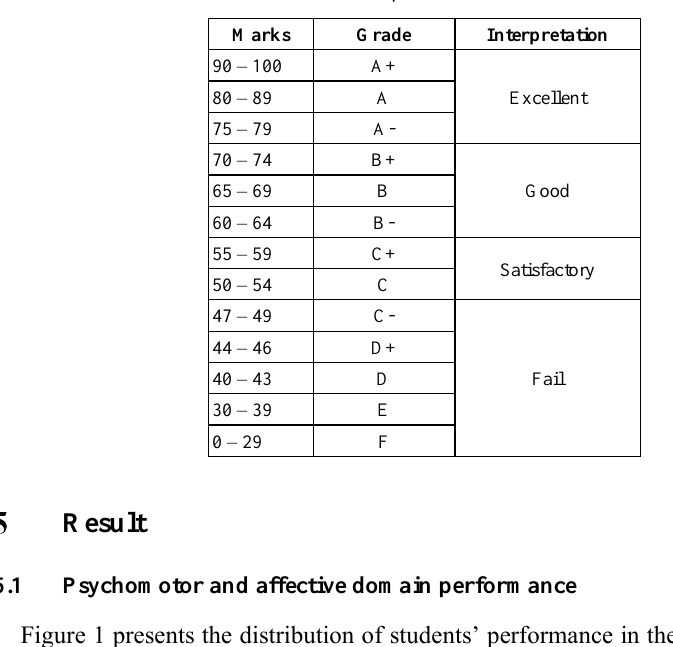
Table 5. Interpretation of the